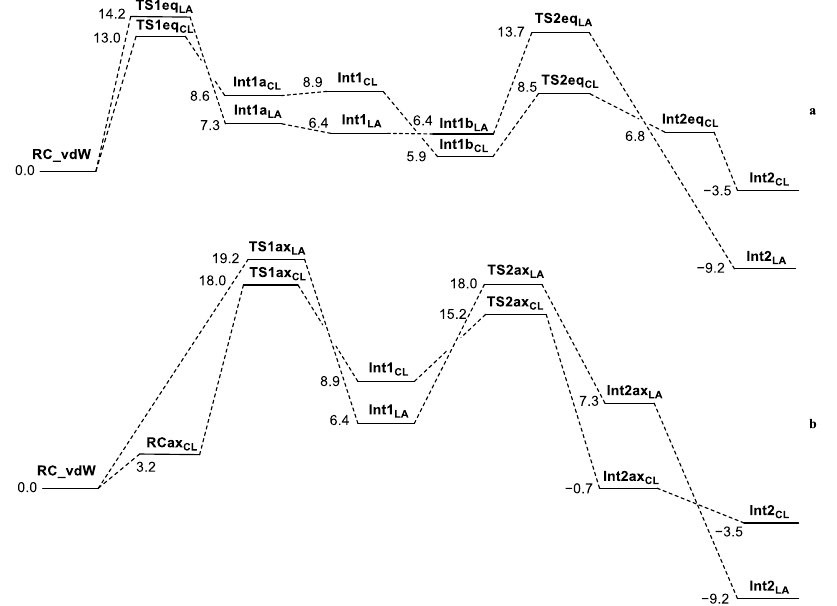
Figure 1. The Gibbs free energy profiles of initiation steps of CL and LA polymerization proceeding via paths with equatorial ( a ) and axial ( b ) addition of monomer.